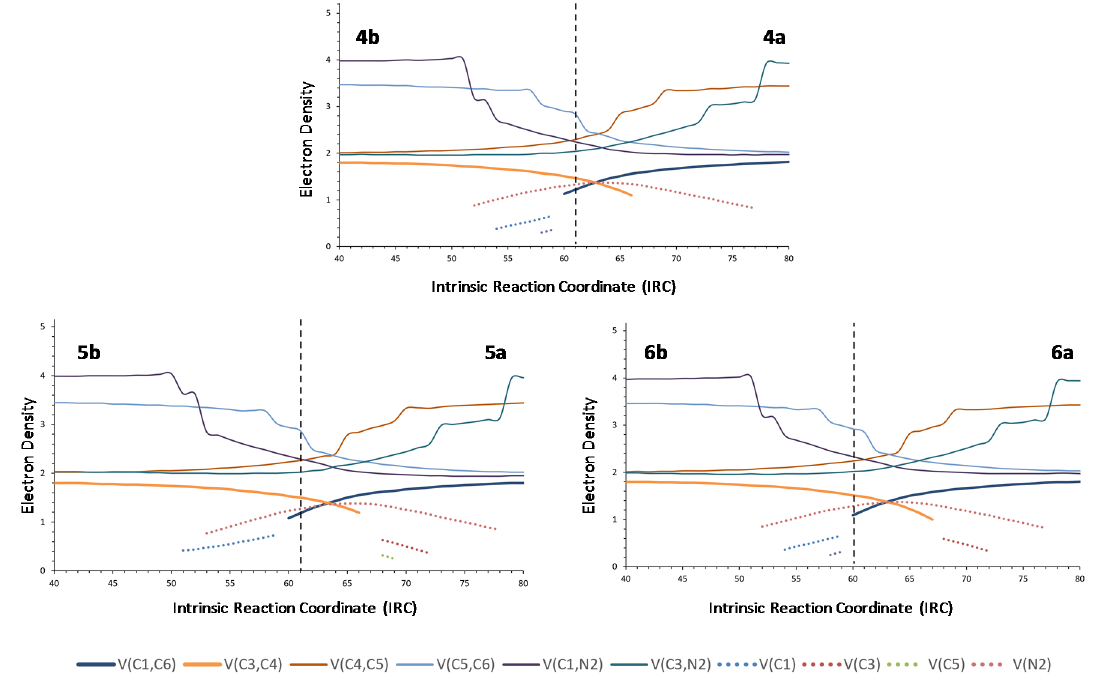
Figure 6. ELF analyses for the 2-aza-Cope rearrangement of nitrones 4 – 6 .